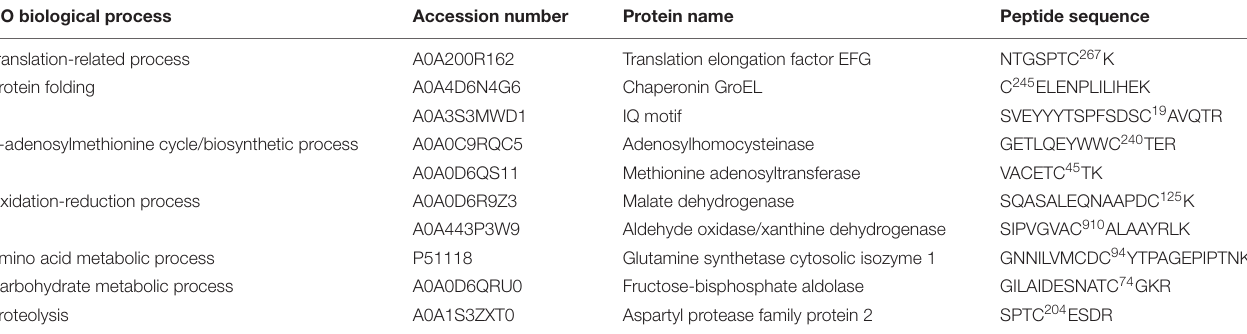
TABLE 2 | Putative S -nitrosated proteins and cysteines sites identified by iodo-TMT reagent from GSNO-treated crude extracts of cell line B2, after 2 weeks of cultivation on proliferation medium MSG (Becwar et al., 1989) supplemented with sucrose and solidified with 0.3% (w/v) Gellan gum. GO biological